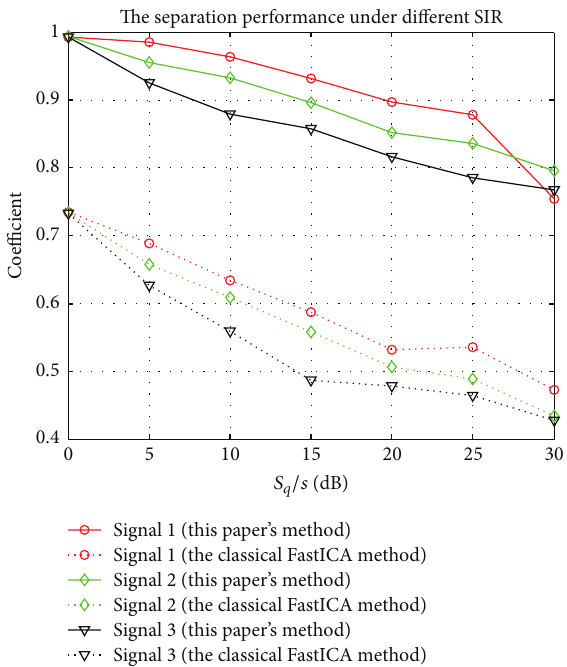
Figure 13: Blind source separation result; this paper’s method has a better performance than classical FastICA